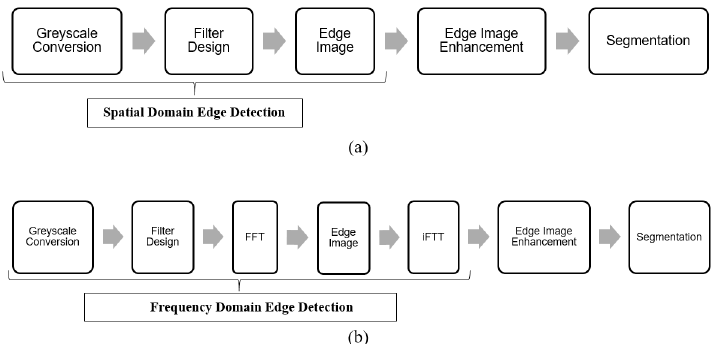
Figure 1 . The steps in the proposed crack detection algorithm. ( a ) The spatial domain and ( b ) the frequency domain.